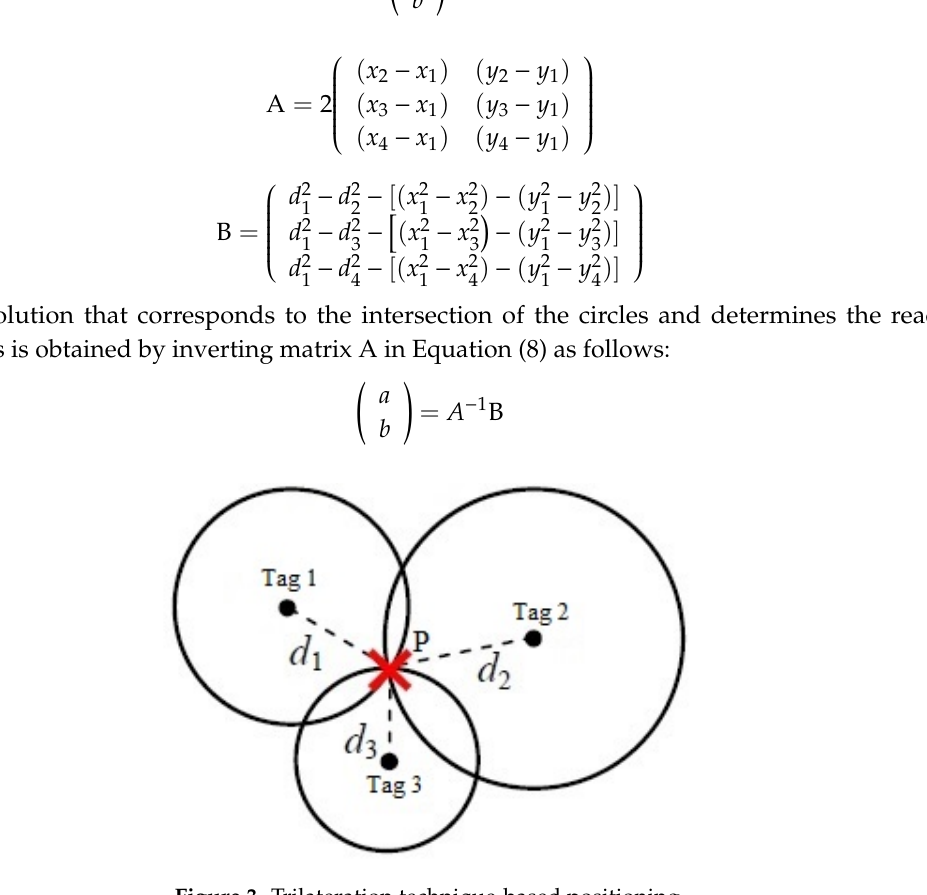
Figure 3. Trilateration technique-based positioning.